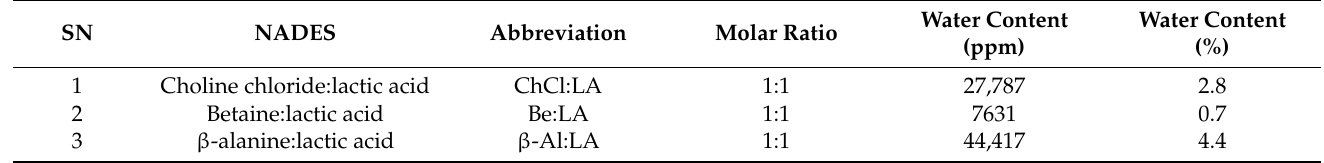
Table 2. List of LA-based NADES samples and their Karl Fischer titration